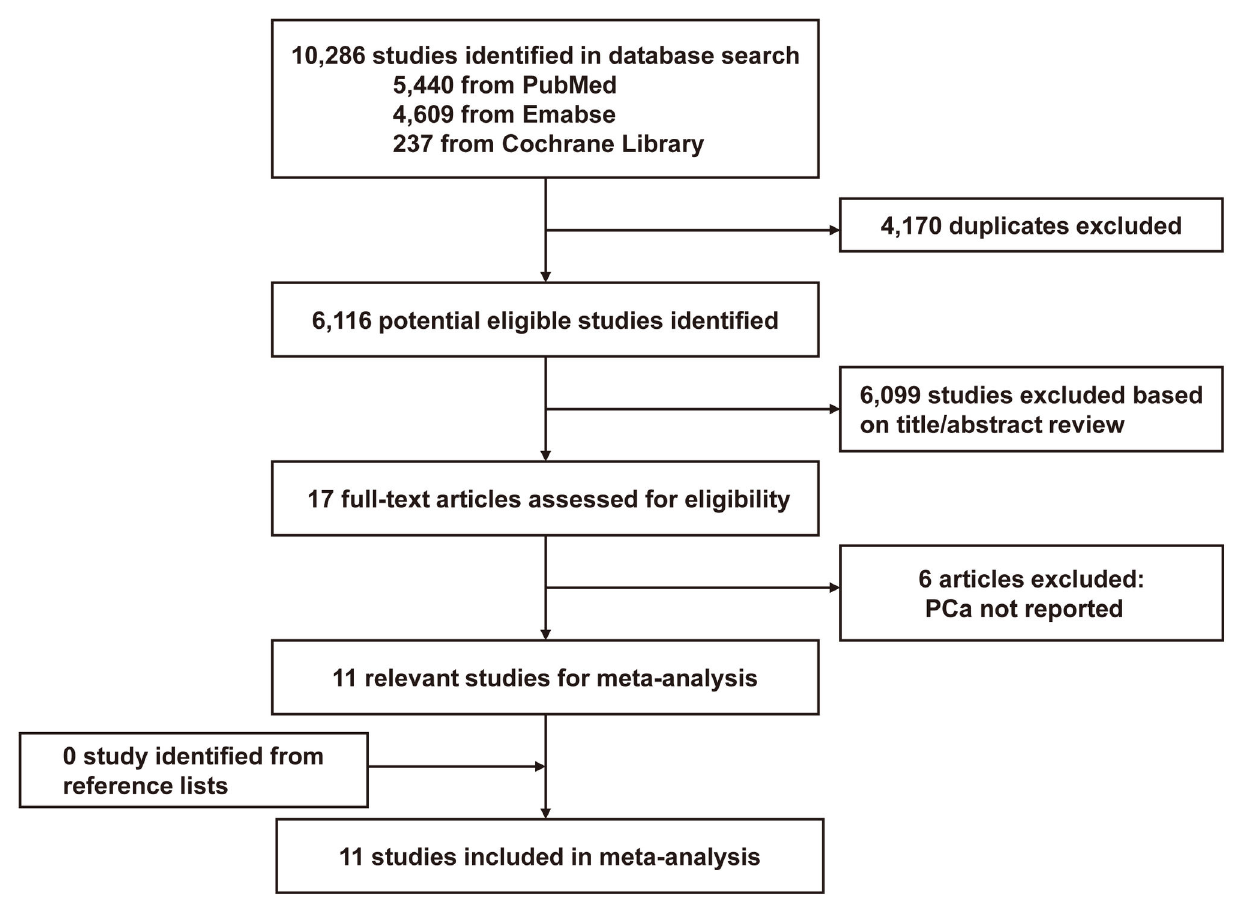
Figure 1. Flow diagram for study